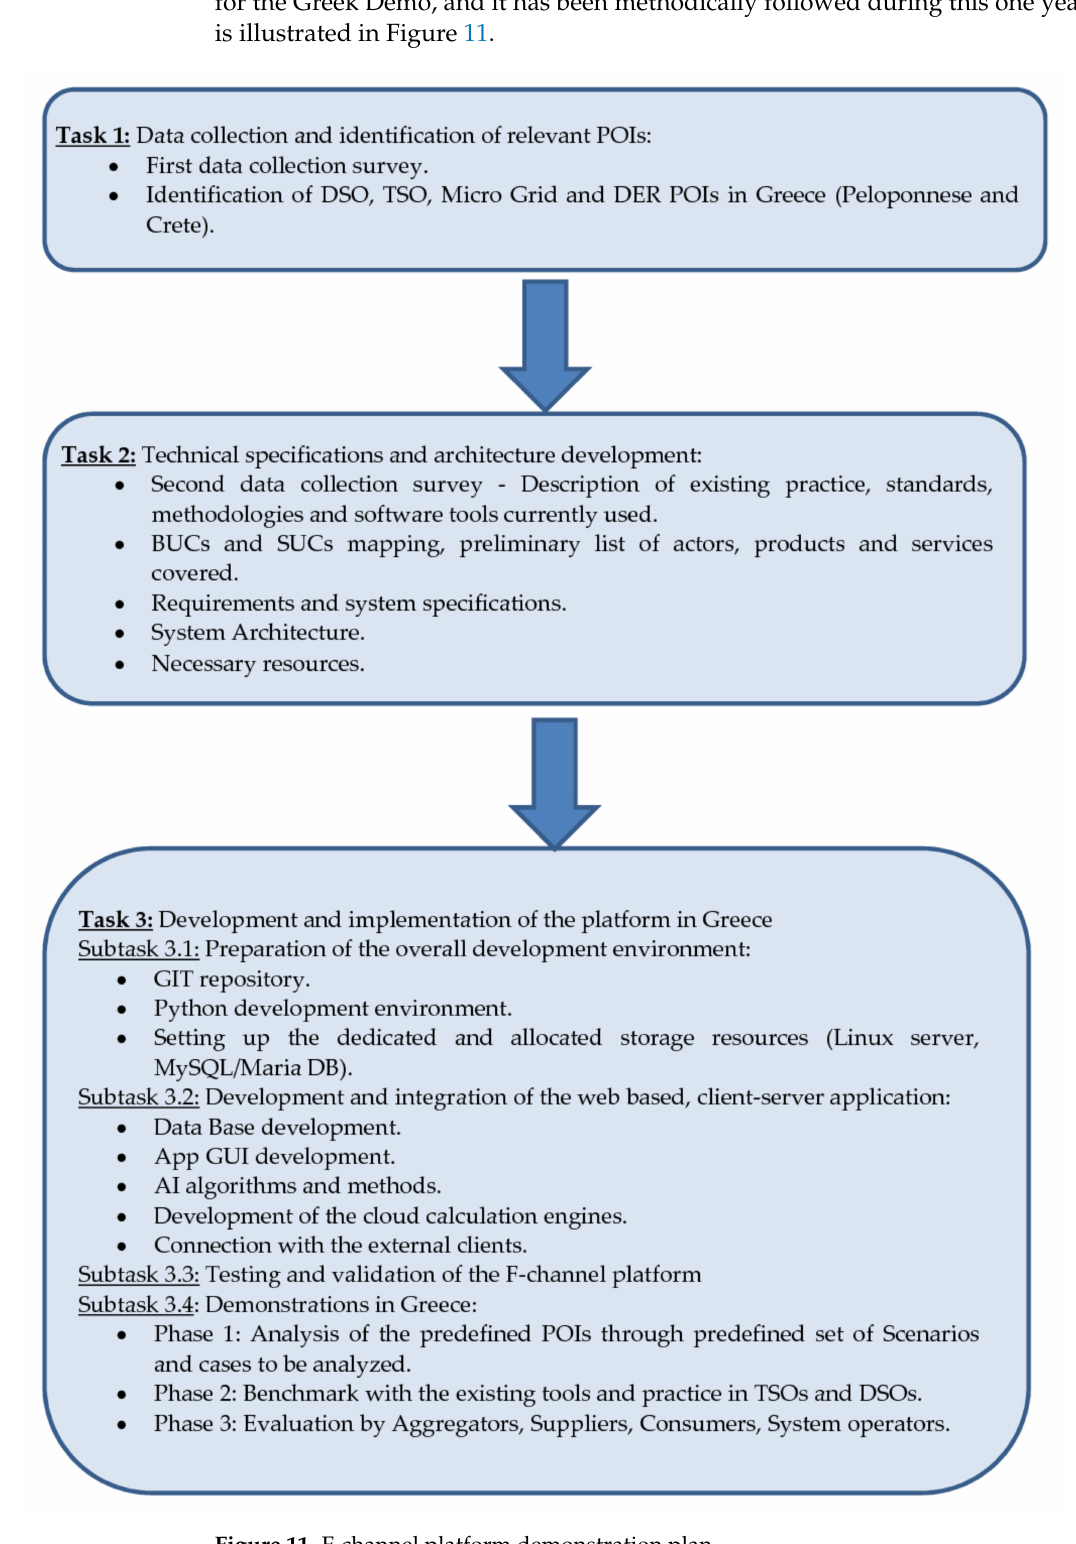
Figure 11. F-channel platform demonstration